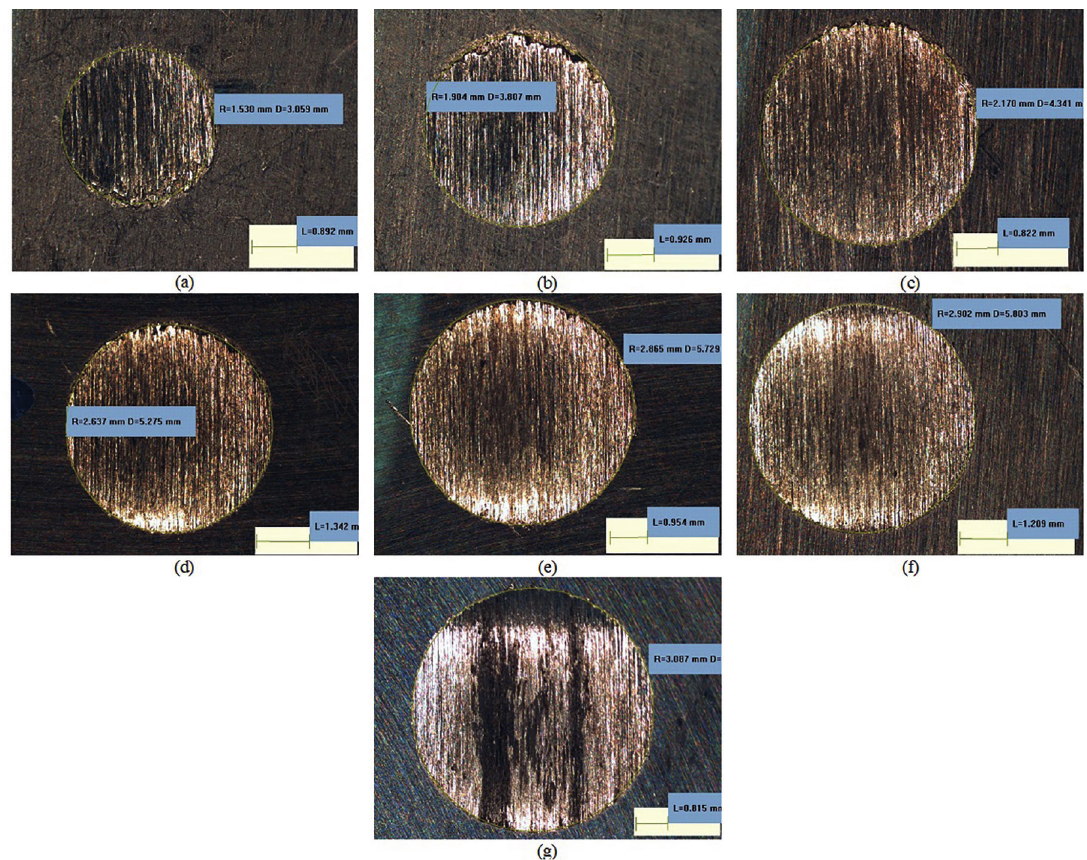
Figure 4: Caps produced in the microwear test for different sliding distances under a 16-N load at (A) 2 minutes, (B) 5 minutes, (C) 10 minutes, (D) 15 minutes, (E) 20 minutes, (F) 30 minutes and (G) 40